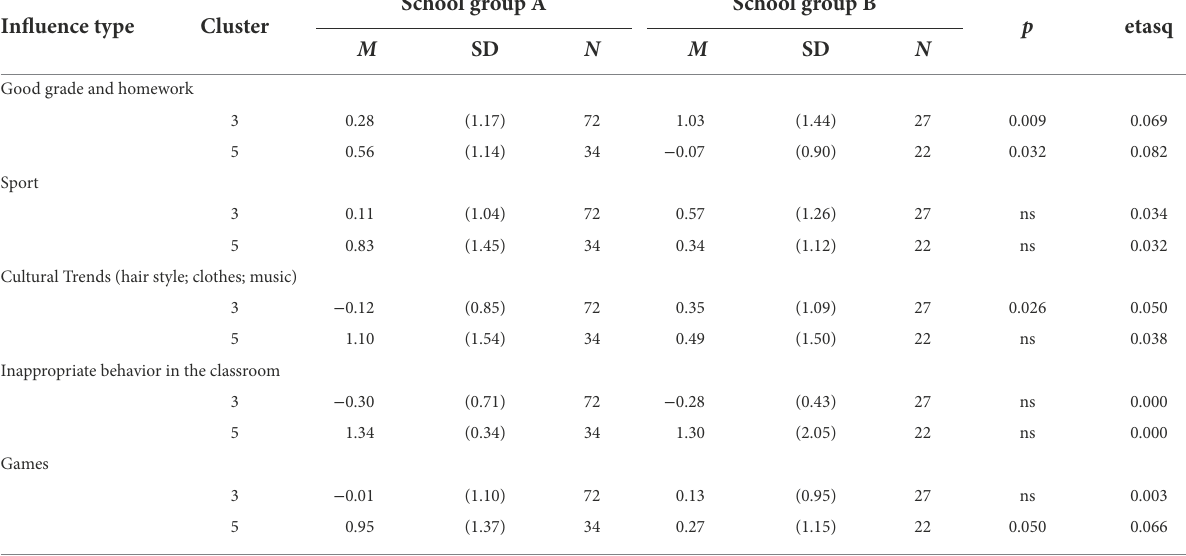
TABLE 7 Comparison of influence of group 3 and group 5 on specific types of influence.